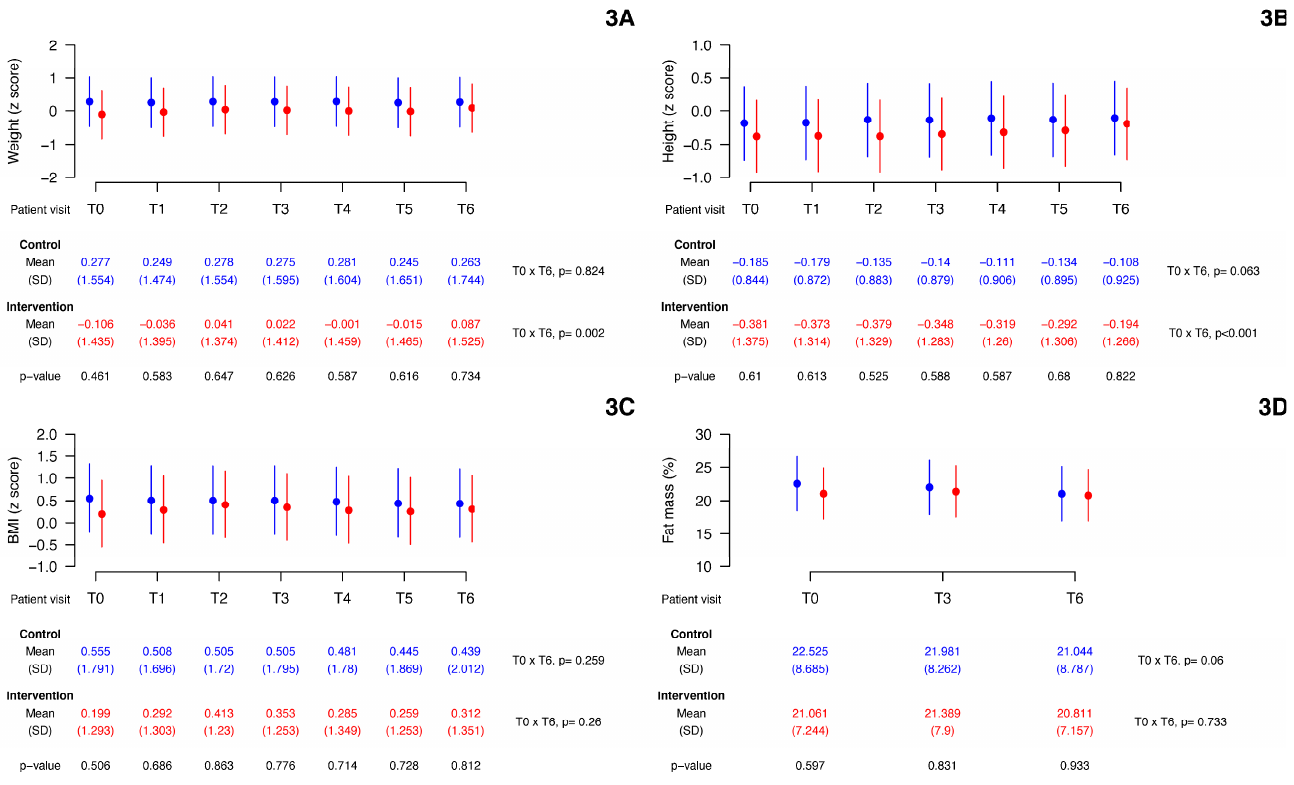
Figure 3. Changes in growth indicators over time. Vertical lines are 95% confidence intervals. p : longitudinal mixed effects linear model. ( 3A ) weight z-scores vs. time; ( 3B ) height z-scores vs. time; ( 3C ) BMI z-scores vs. time; ( 3D ) fat mass percentage vs. time.